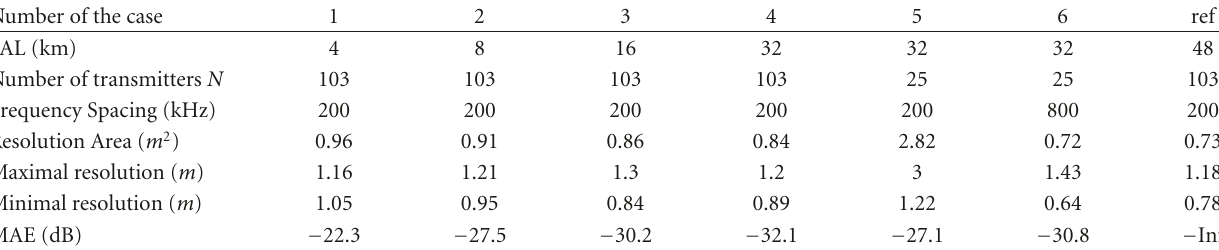
Table 2: Results of resolution parameters and MAE for Cases